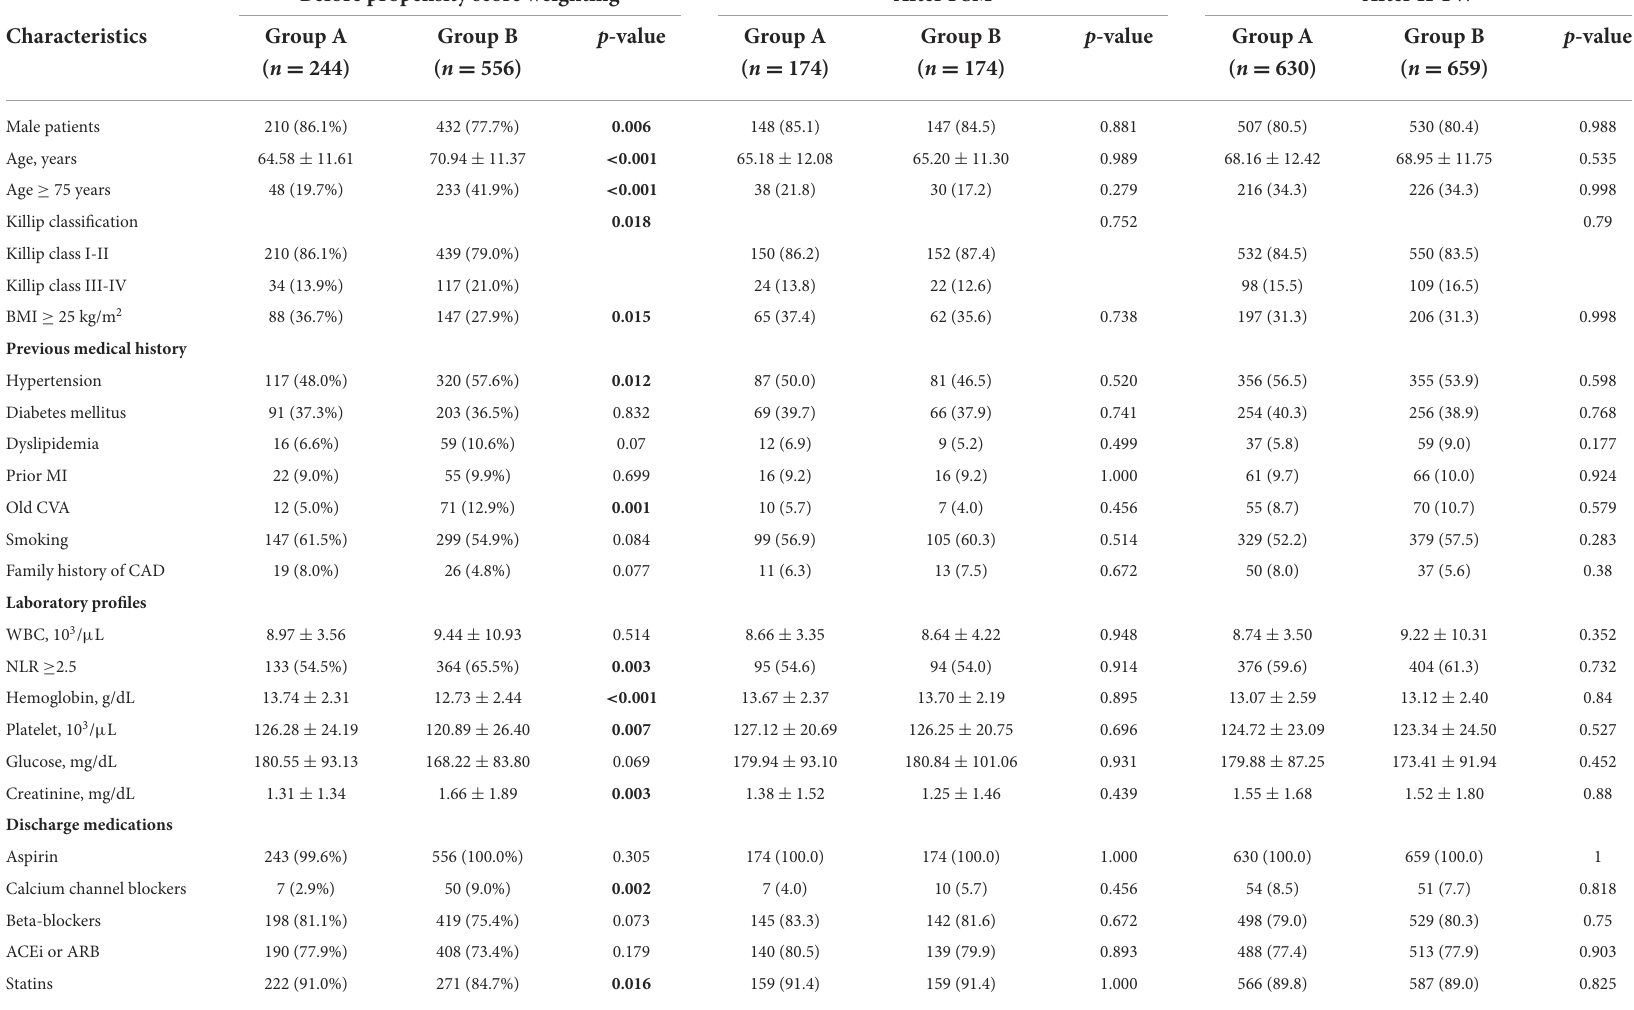
TABLE 1 Baseline characteristics of the study